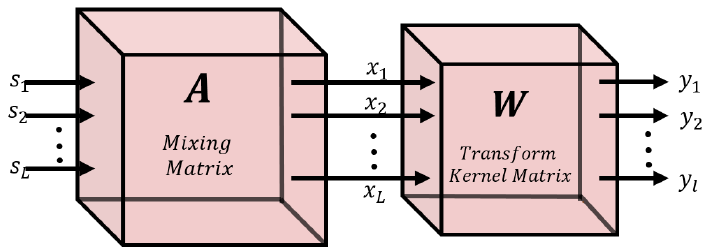
Figure 1. Linear model of FastICA. Adapted from Ref